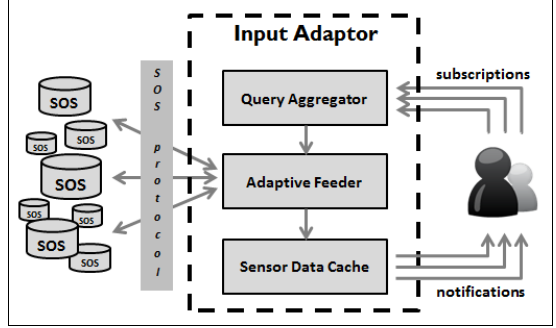
Figure 1. System architecture and